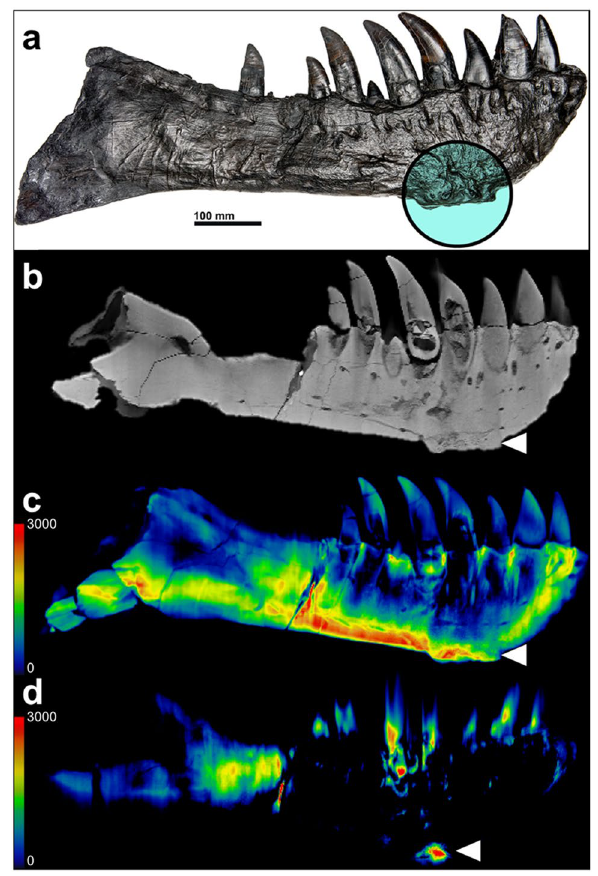
Figure 2. Diseased left dentary of the Tyrannosaurus rex MB.R. 91216. Photograph ( a ), conventional CT-reconstruction ( b ) and DECT-based calcium ( c ) and fluorine maps ( d ) of the left dentary in sagittal orientation. The circle in ( a ) and the arrowheads in ( b – d ) indicate the focal exophytic mass on the ventral bone surface at the level of the 3rd to 5th tooth-root. The DECT-material maps demonstrate a diffuse and heterogenous calcium concentration ( c ) but a focal fluorine accumulation in the central part of the exophytic mass ( d ). Red indicates high concentrations of the investigated element measured in Hounsfield units (color bar in the left lower